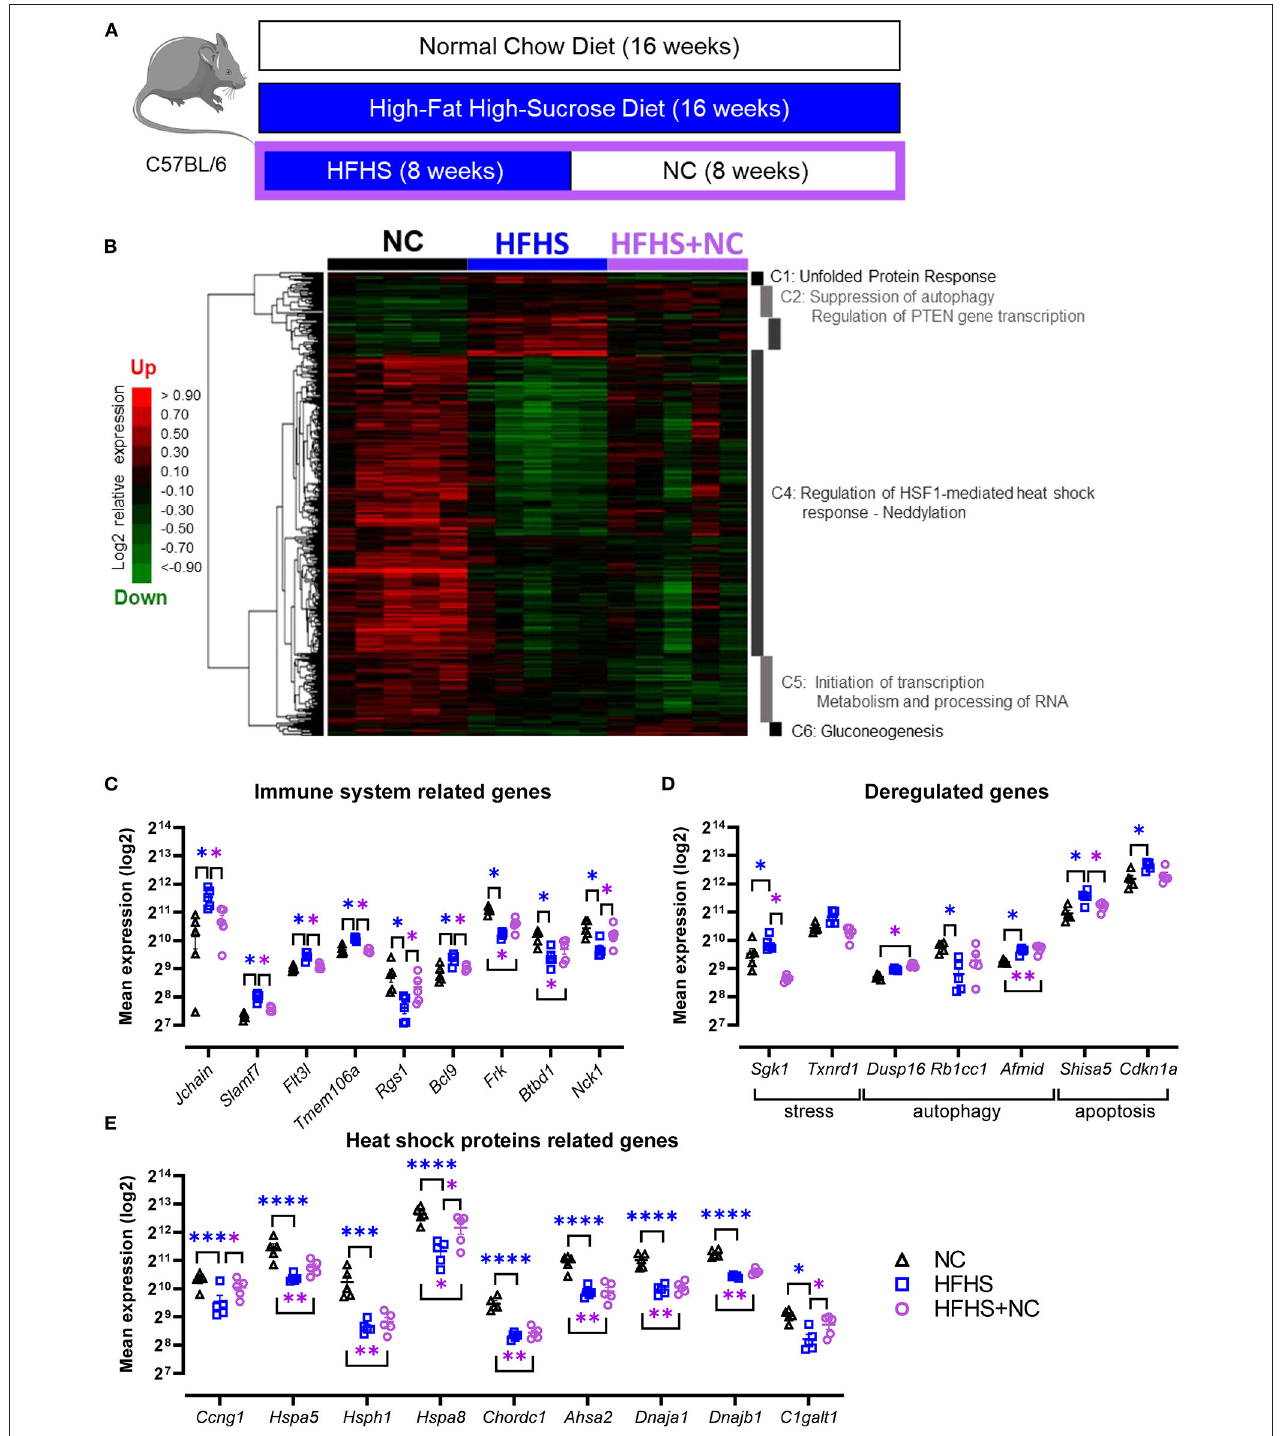
FIGURE 5 | Partially reversible effects of high-fat high-sucrose diet on the colonic transcriptome. (A) Experimental design. Mice were fed with a normal chow diet (NC, N = 10) or a high-fat high-sucrose diet (HFHS, N = 10) for 16 weeks or 8 weeks and then switched back to NC for 8 weeks (HFHS + NC, N = 10). (B) Hierarchical clustering heatmap of the most variable genes in NC vs. HFHS vs. HFHS + NC fed mice. (C–E) Expression levels of relevant genes in clusters C1 to C6 for groups of mice fed with NC, HFHS or HFHS + NC, mean expression values (log2) are plotted with standard deviations for up- and down-regulated genes. FDR * ≤ 0.05, ** < 0.01, *** < 0.001, **** <